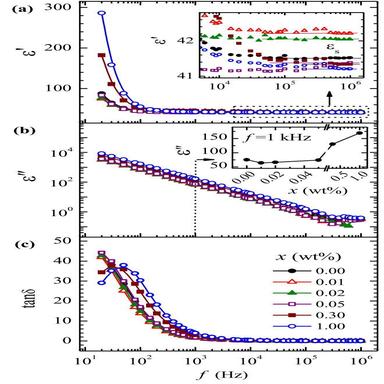
Complex dielectric permittivity (e0 and e00) and dielectric loss tangent (tand) spectra of GLY/x (wt%) ZnO nanofluids (x = 0.00, 0.01, 0.02, 0.05, 0.30, and 1.00), at 25 C. Inset of (a) shows the enlarged view of e0 spectra in the frequency range from 5 kHz to 1 MHz, and inset of (b) shows the variation in e00 values with x (wt%) amounts of ZnO for the nanofluids at 1 kHz.